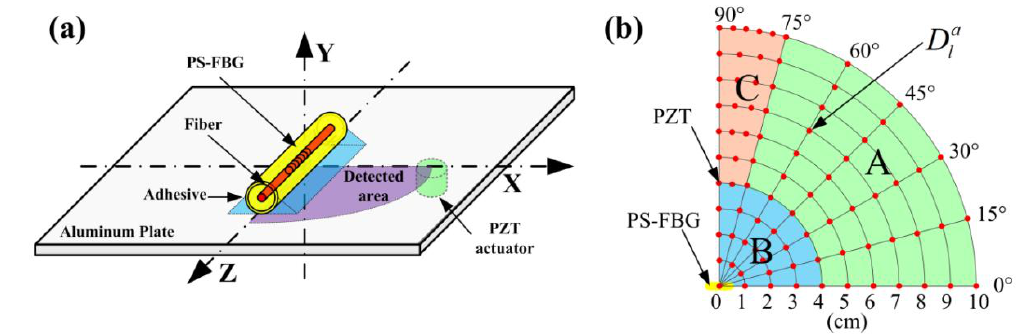
Figure 1. Schematic diagram of experimental setup. ( a ) Acousto-ultrasonic method was used to research the sensitivity distribution properties of a PS-FBG sensor on an aluminum plate. ( b ) Data were measured on 82 different dots distributed in a quarter-circle